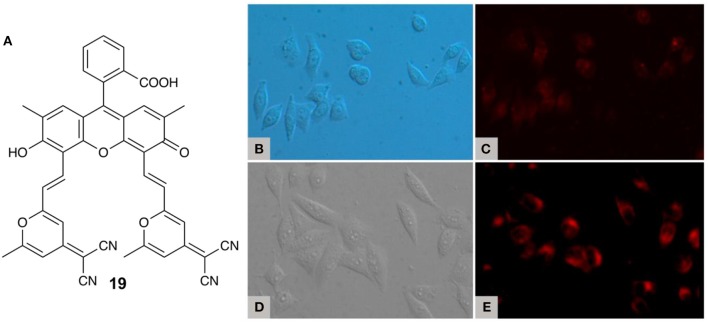
(A) Fluorescein derivative 19; (B) bright-field image and (C) steady-state luminescence (510–560 nm excitation) of MCF-7 cells immunostained with 19 (20 μM) and BSA (40 μL, 10 mM) at 37°C; (D) bright-field image and (E) time-resolved luminescence (510–560 nm excitation) of MCF-7 cells stained with 19 (20 μM) and BSA (40 μL, 10 mM) at 37° C. Adapted from reference (Xiong et al., 2014) with permission from the American Chemical Society.